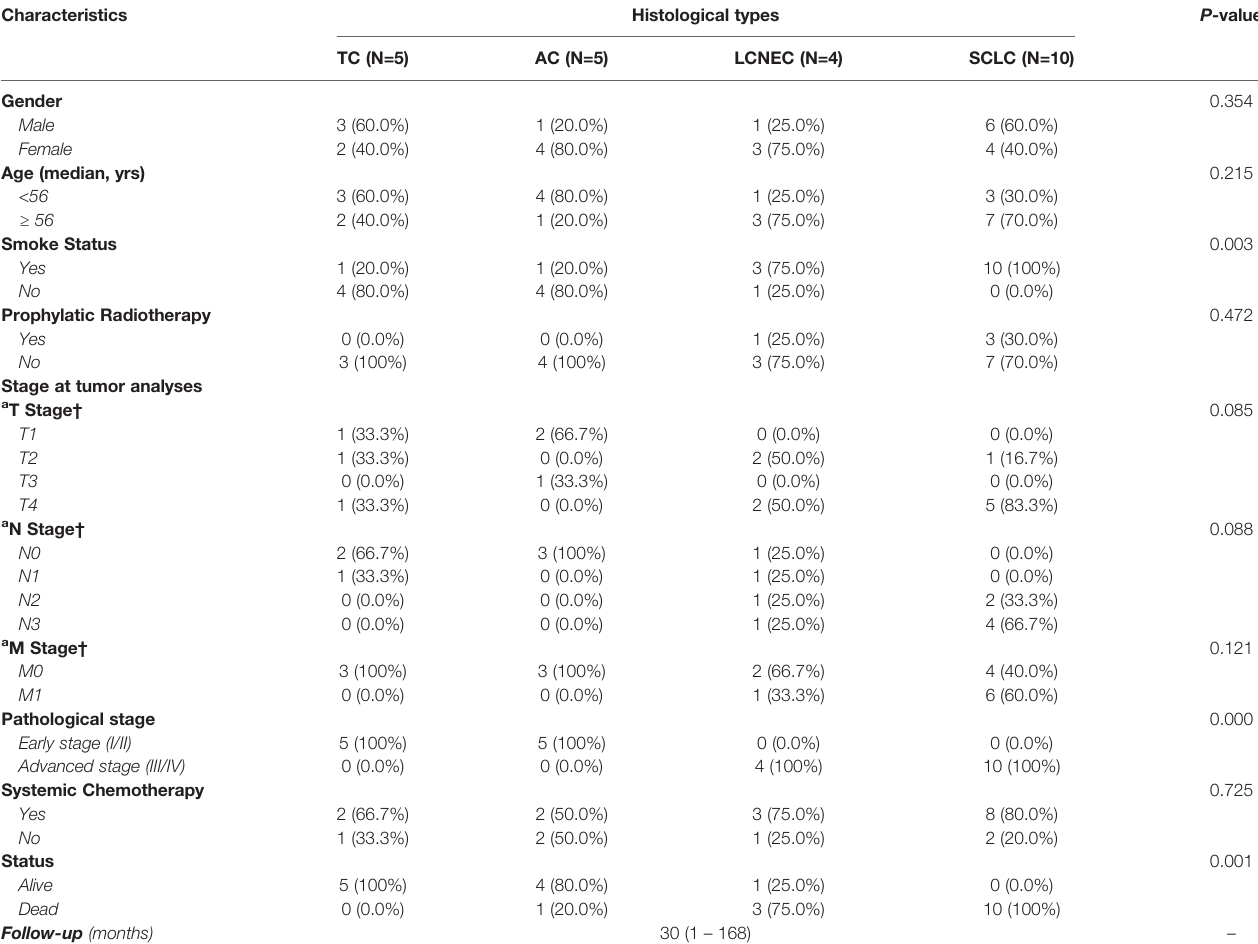
TABLE 1 | Demographic and clinicopathologic characteristics of patients diagnosed with PNENs by Person ’ s Chi-Square test (P<0.05). Characteristics